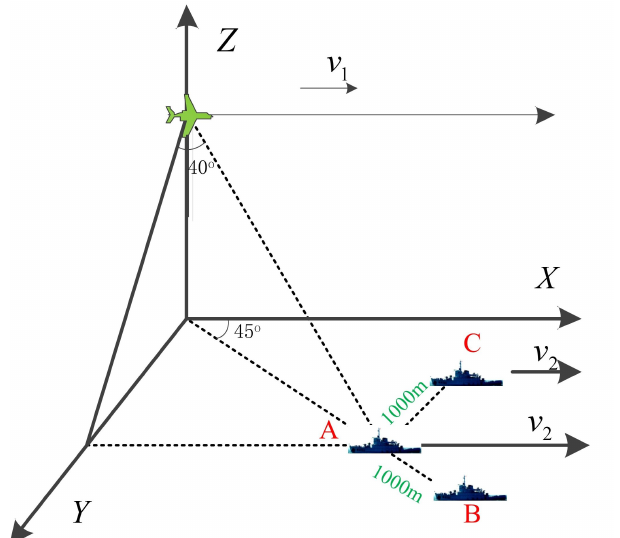
Figure 9. Geometric diagram of ship target imaging simulation by airborne radar.